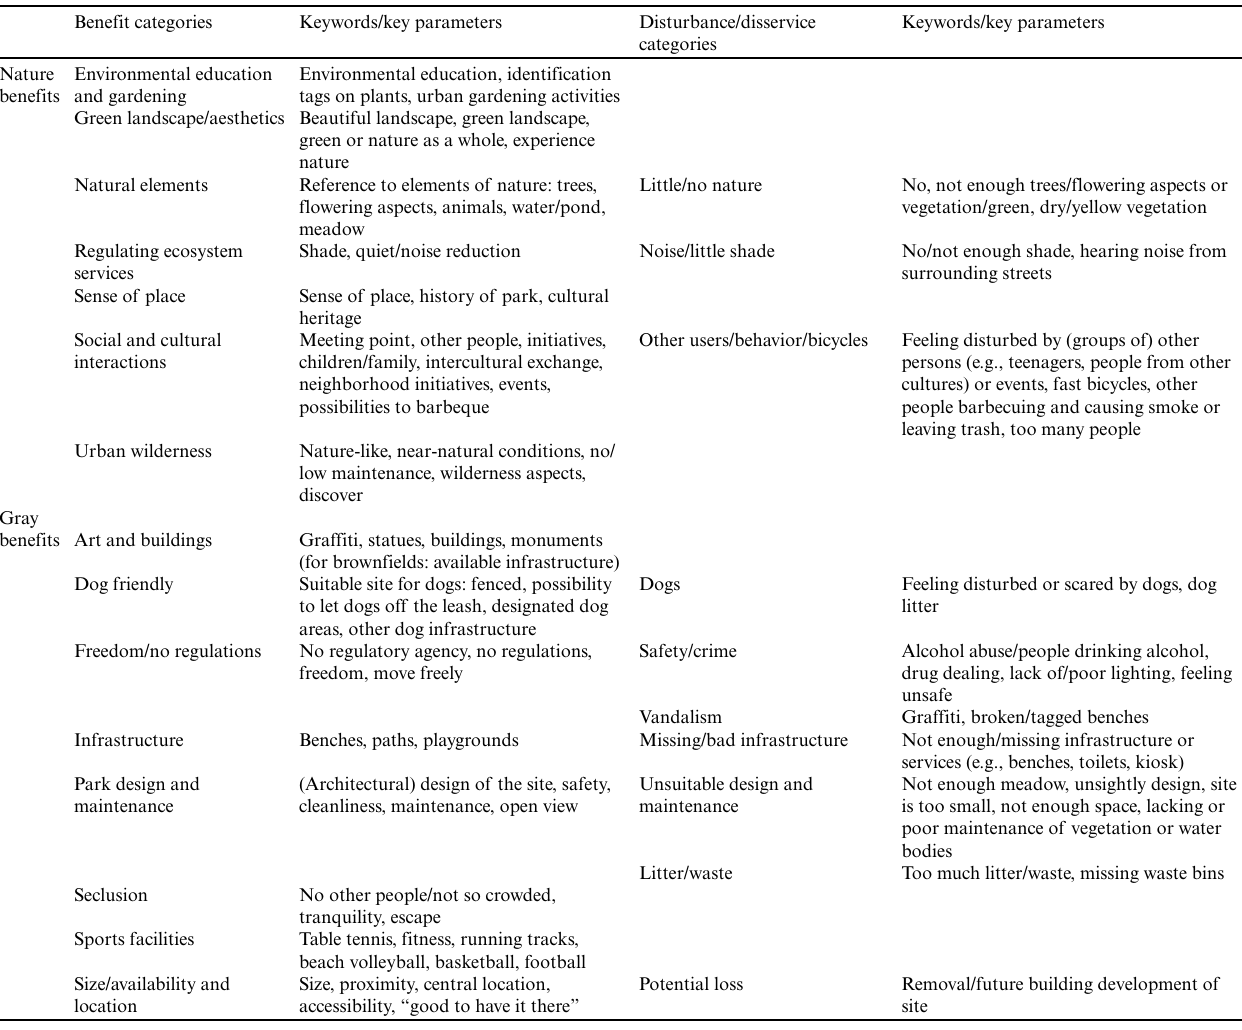
Table 1 . Categories of benefits and their (partly) contradicting disturbances perceived by respondents in urban parks and brownfields. Several answers were possible. Answers by respondents mentioning several keywords within one category (e.g., flowering aspects and trees) were counted as one.